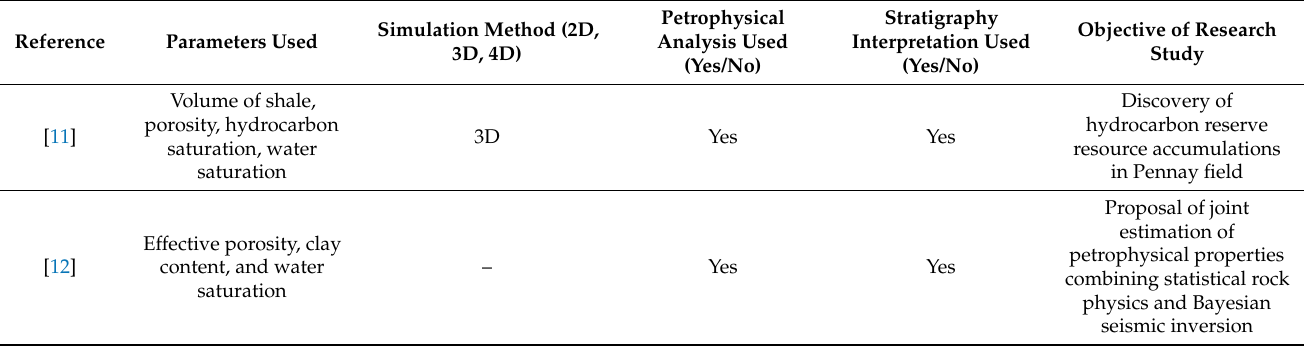
Table 1. Findings of literature